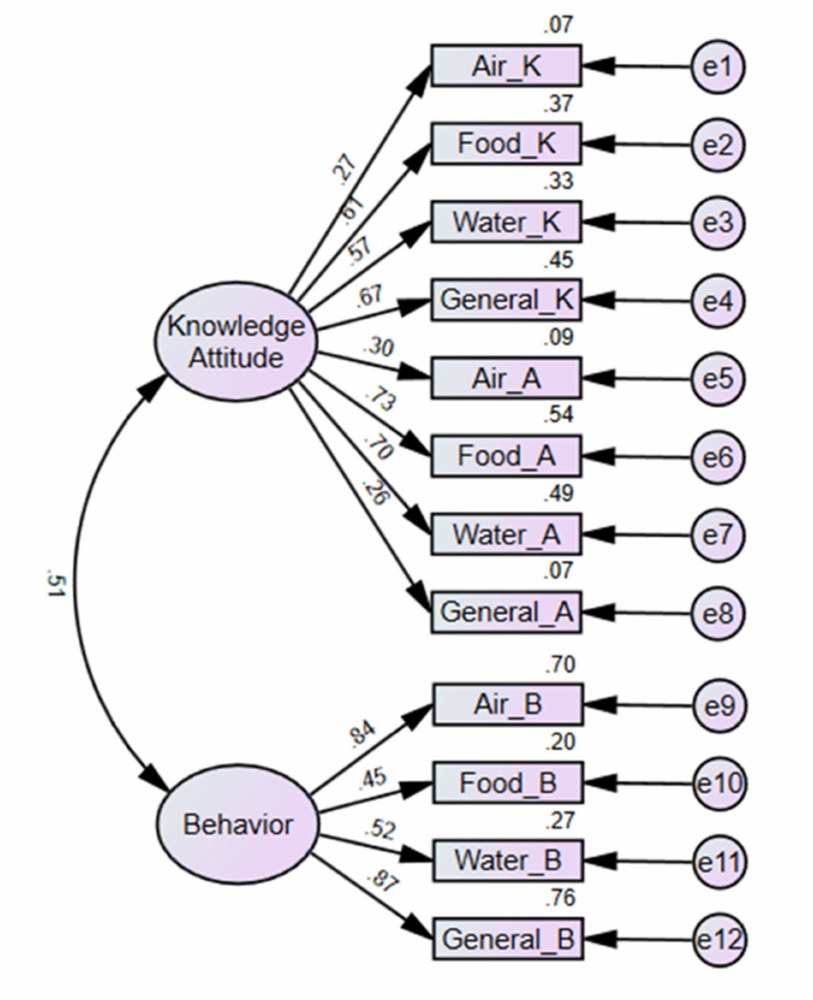
Figure 1. Confirmatory factor analysis of the Korean version of the Environmental Health Literacy (K-EHL)